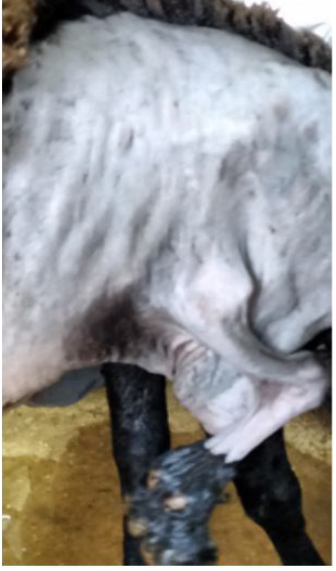
Figure 5. Preoperative trichotomy of the thorax and accessory limb.